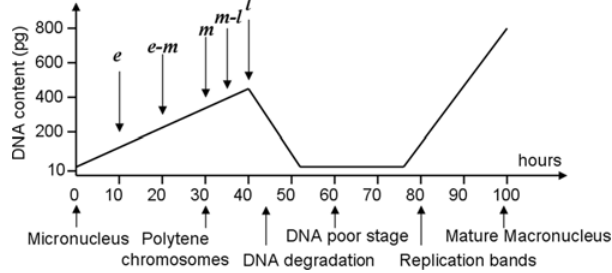
Figure 2. Macronuclear development in Stylonychia lemnae (adopted from [ 49,52 ] and consistent with present lab conditions) showing time-points for DNA isolation ( e =early; e-m =early-middle; m =middle; m-l =middle-late; and l =late). doi:10.1371/journal.pone.0002330.g002 PLoS ONE |